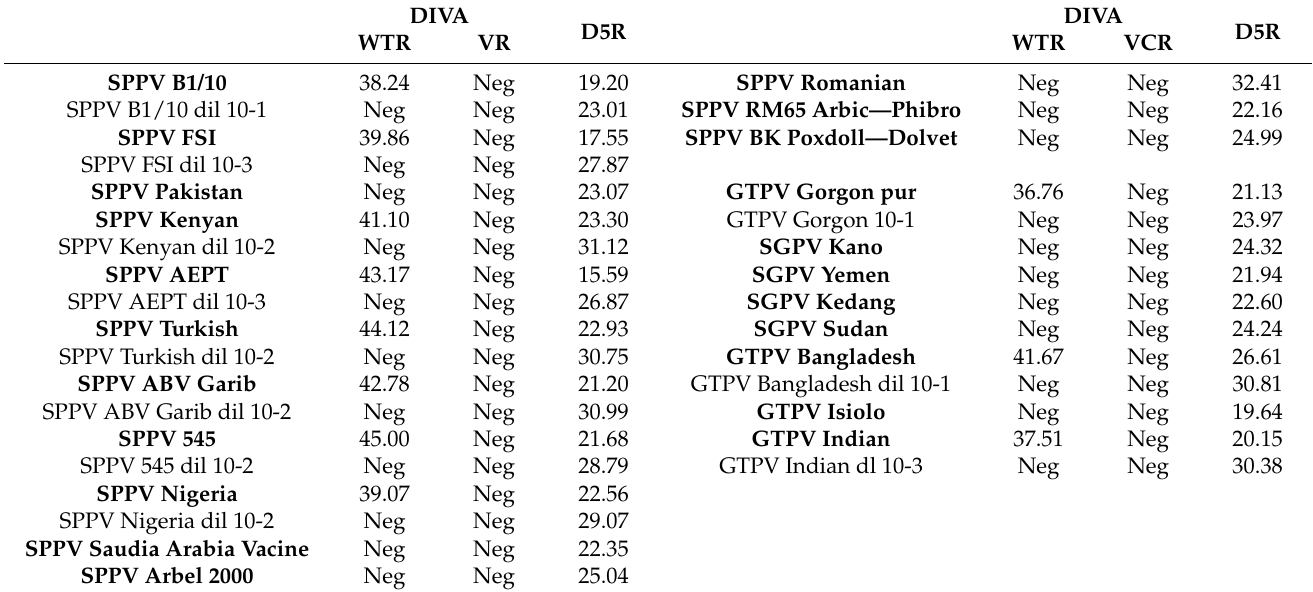
Table 3. Real-time PCR results of sheep- and goatpox strains. Bold: the undiluted sample.